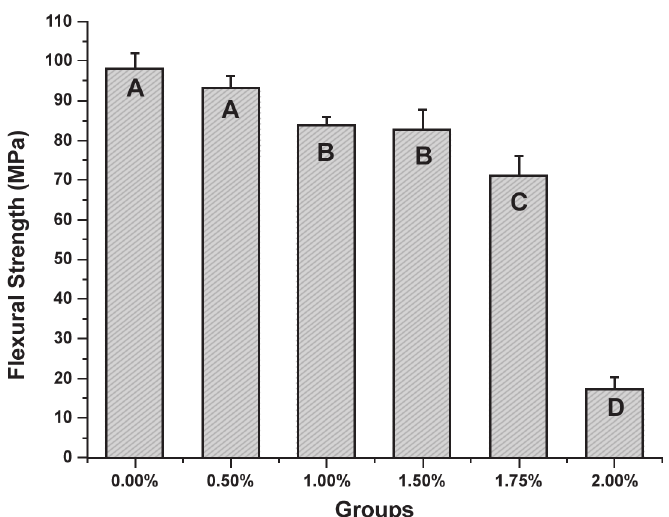
Figure 2- Mean flexural strength values for all groups (bars represent standard deviations). The same capital letters indicate no statistically significant difference. (Tukey’s test,